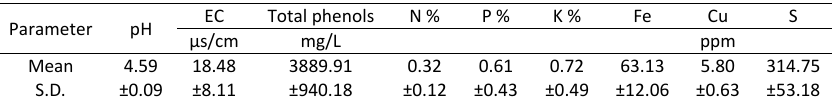
Table 1.Olive mill wastewater characteristics